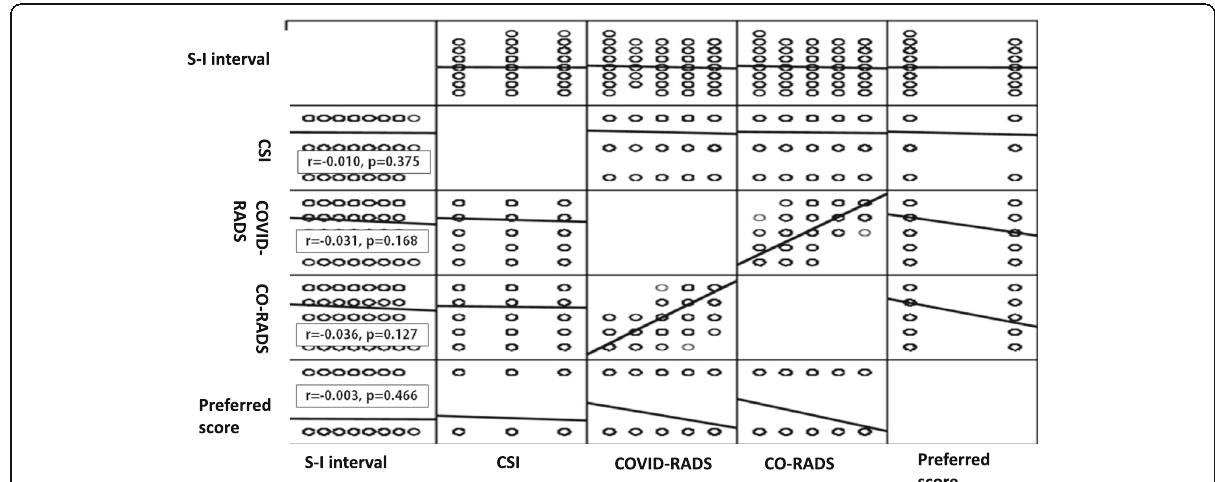
Fig. 7 Correlation matrix for the symptoms to imaging duration interval (S-I interval) versus clinical suspicion index (CSI) and assessment of both lexicon score results (CO-RADS or COVID-RADS) or even the preferred score among COVID-19